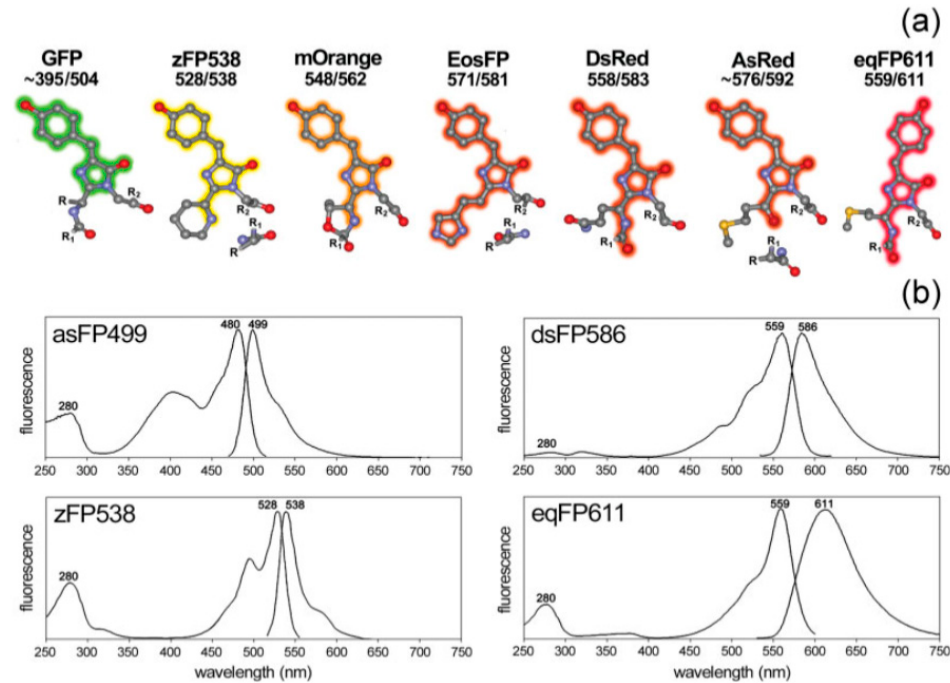
Figure 4. ( a ) Structural schemes of di ff erent chromophore groups (atom color coding: grey—carbon, red—oxygen, blue—nitrogen, yellow—sulfur; R / R 1 / R 2 symbolize protein rests); ( b ) excitation and emission spectra of di ff erent fluorophores. Reprinted with permission from [141]. Copyright 2009, John Wiley and Sons.